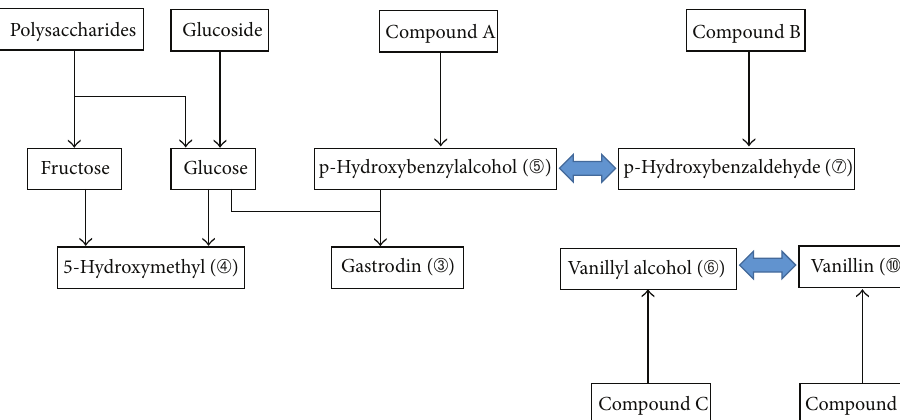
Figure 7: The possible chemical reaction pathways in Tianma under